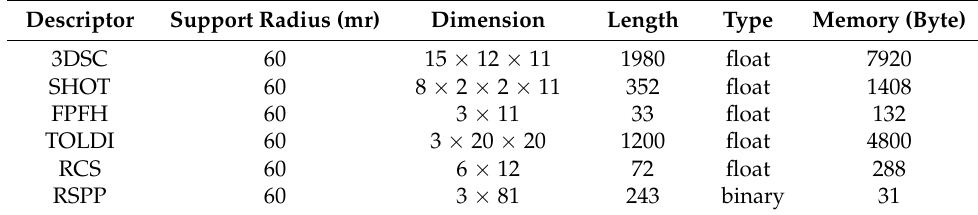
Table 5. Feature descriptor parameter Settings.